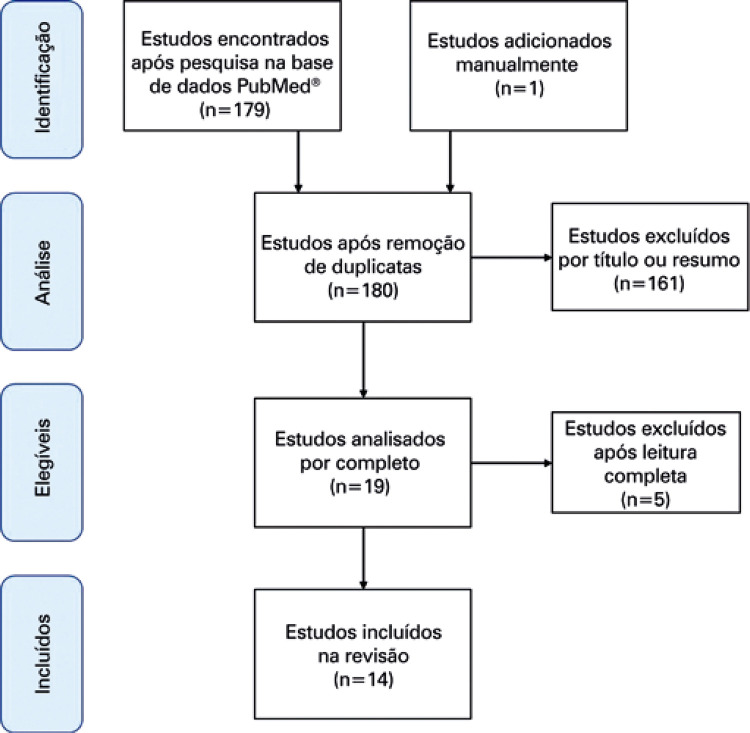
Diagrama Preferred Reporting Items for Systematic Reviews and Meta-Analyses (PRISMA)